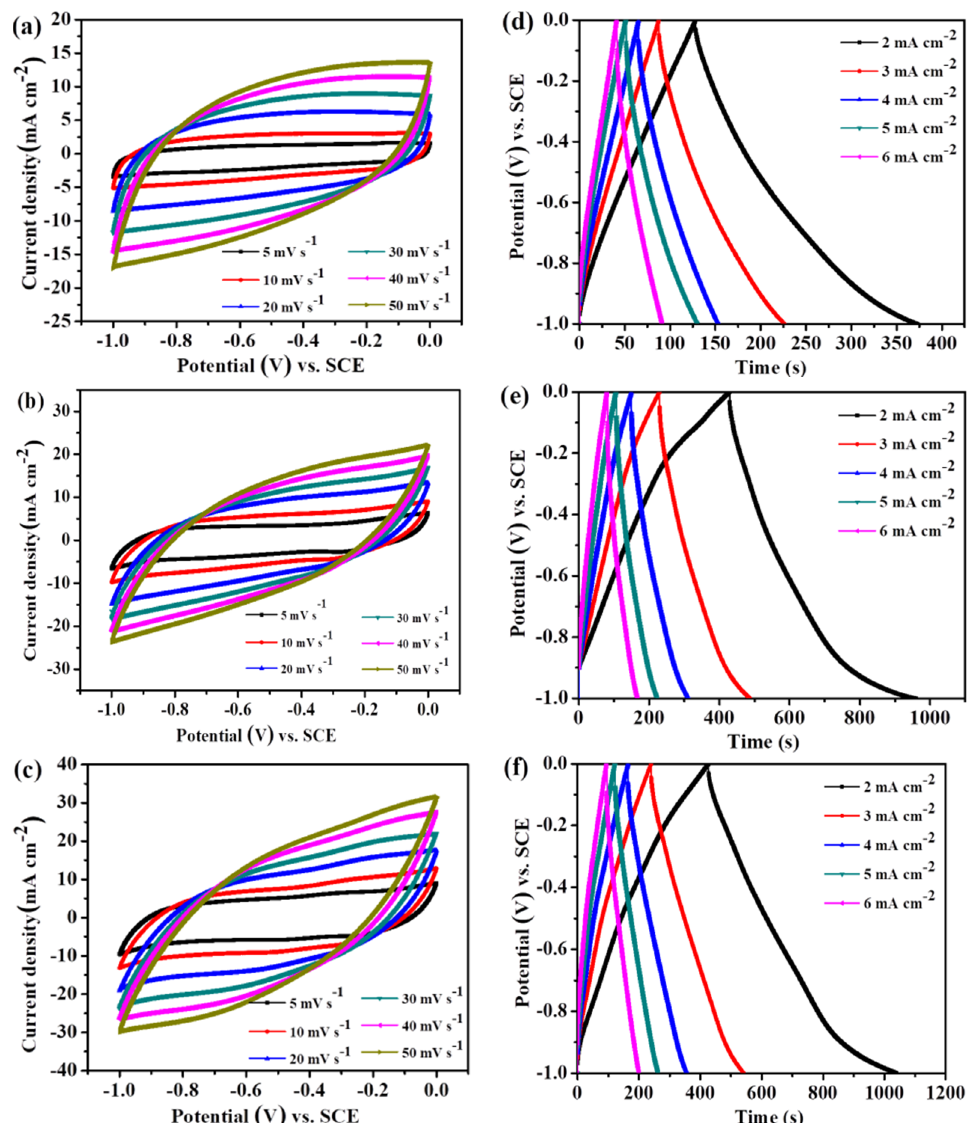
Figure 9. ( a – c ) CV curves at various scan rates and ( d – f ) GCD curves at various current densities of ( a , d ) the f -CNT, ( b , e ) the V 2 O 5 / f -CNT, and ( c , f ) the V 2 O 5 / f -CNT/PPy electrodes.